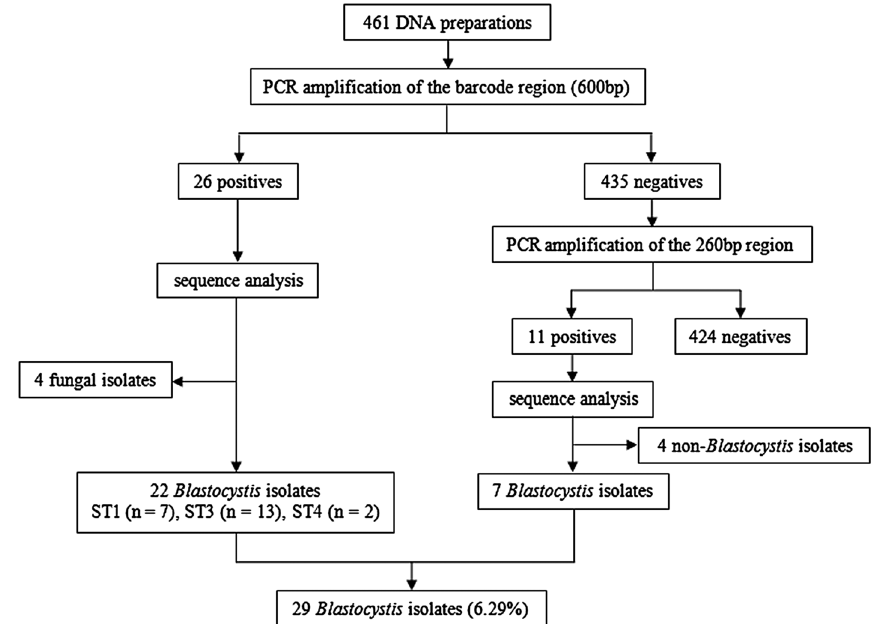
Figure 1. Flow diagram of prevalence and subtype identi fi cation of Blastocystis